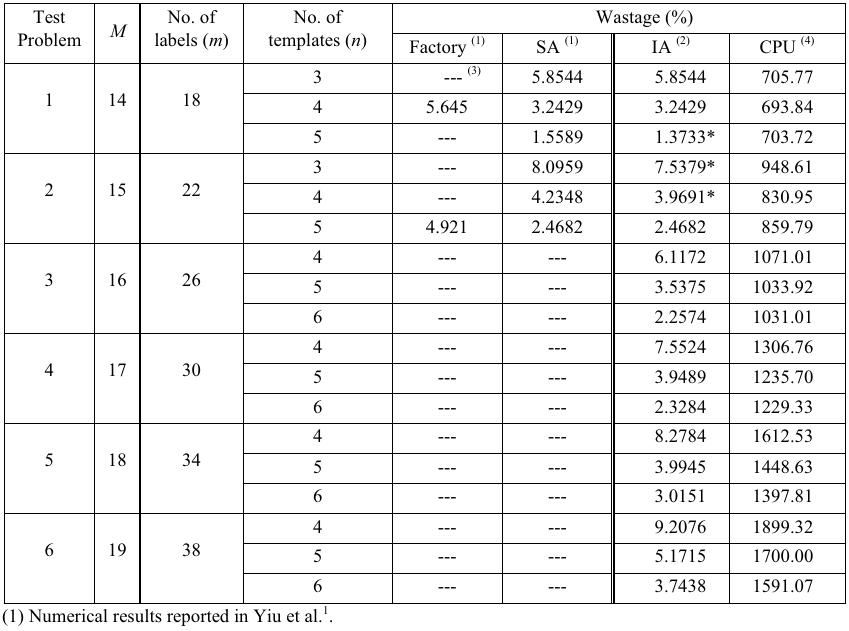
Table 2. Numerical results of LPP by various approaches